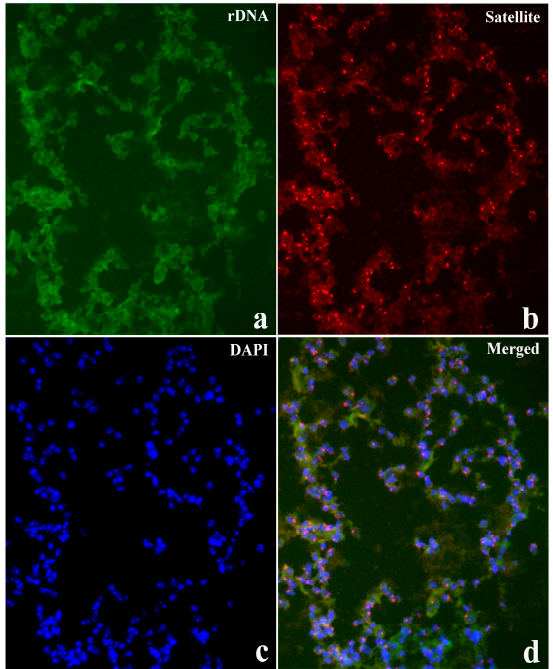
Figure 8. Simultaneous ribosomal DNA and AAGAG repeat probe hybridization to Drosophila neuroblast nuclei carrying the bw D allele prepared in pH 7.0 omitting chromosomal DNA denaturation. Ribosomal DNA probe channel ( a , rDNA), AAGAG probe channel ( b , Satellite), nuclei stained with DAPI ( c , DAPI) and the corresponding merged signals ( d , Merged).